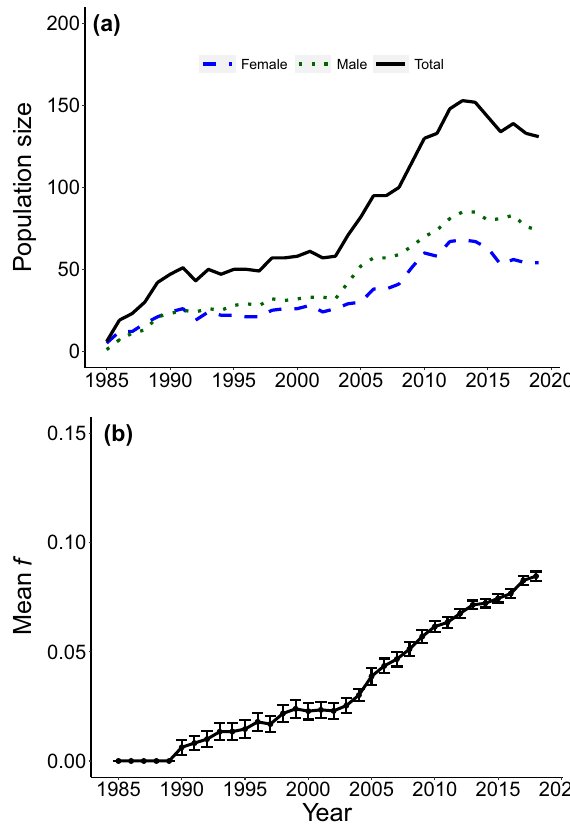
Figure 1. Census size and inbreeding level through time of the sihek ex-situ population. ( a ) Number of ex-situ hatched individuals in the population and ( b ) mean population inbreeding level ( f ), with standard error